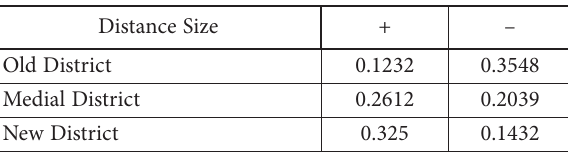
Table 10. Determining the distance from the ideal positive and